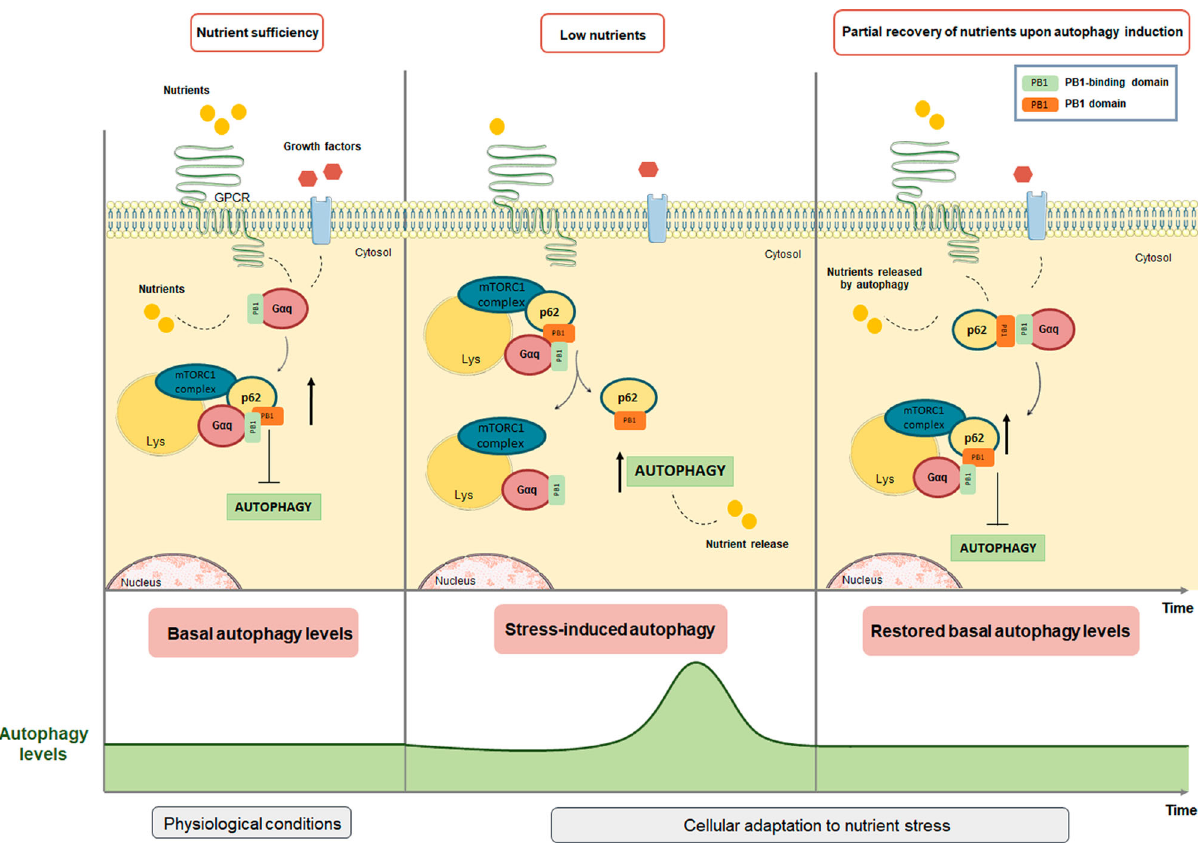
Fig. 8 Proposed scaffolding role of G α q in the assembly of active mTORC1 complex to control autophagy in response to different types of nutrient stress. Upper part: In nutrient-suf fi ciency conditions, the presence of serum, amino acids, or glucose would foster the PB1-like interaction between G α q and p62, leading to basal mTORC1 stimulation and preservation of homeostatic autophagy levels. Upon starvation, G α q/p62 dissociation would facilitate